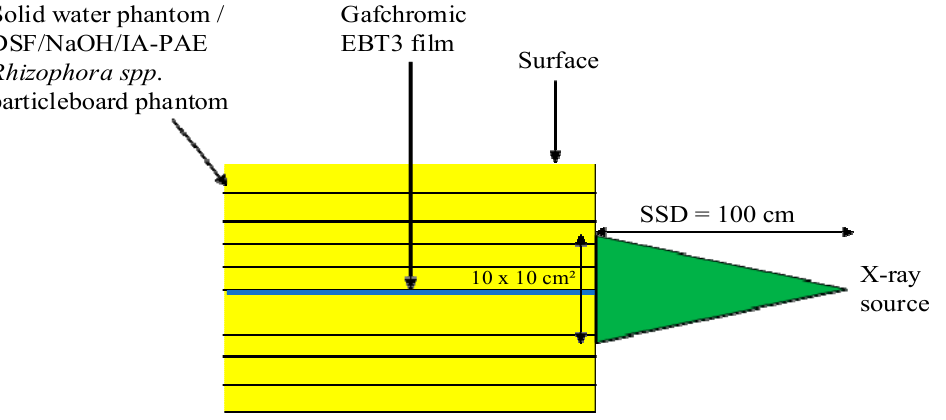
Figure 3. Experimental setup used for PDD evaluation.